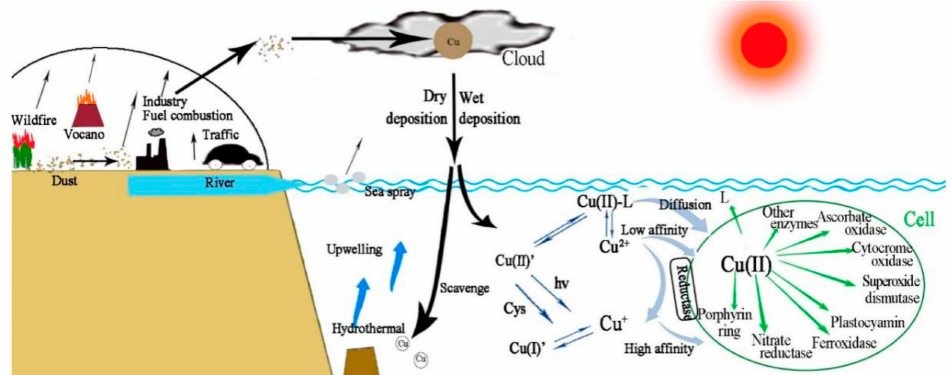
Figure 3. The scheme of Cu sources, transport, and transformation in marine ecosystems. Natural and anthropogenic sources of Cu, as well as their relative transport processes, are illustrated. The detailed description can be seen in relevant sections. After aerosol Cu is deposited into the seawater, some of it is scavenged, while some is taken up by phytoplankton. The uptake pathways are also shown as di ff usion as well as low- and high-a ffi nity transports in the